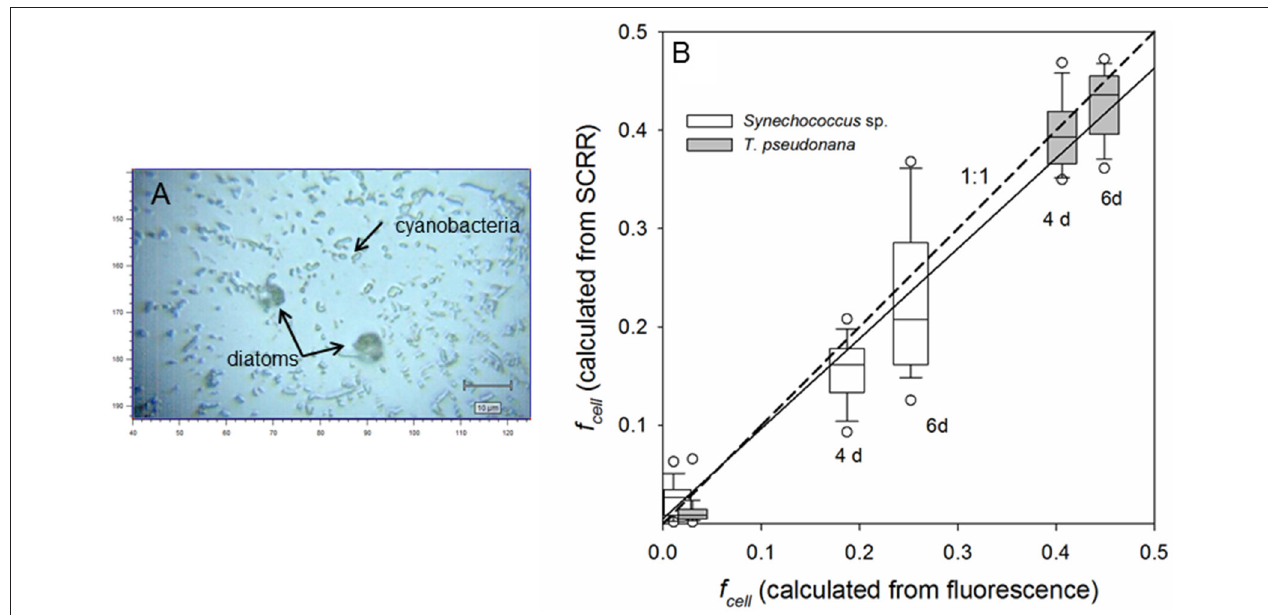
FIGURE 8 | Bright-field image (A) and measurement of fractional labeling (B) of single cells in artificial assemblages through time . Parallel cultures of a fast-growing diatom, Thalassiosira pseudonana ( µ pop = 0.483 day − 1 ) and a slow-growing cyanobacterium, Synechococcus sp. ( µ pop = 0.161 day − 1 ) in labeled ( f media = 0.48) and unlabeled ( f media = 0.011) were subsampled through exponential growth phase, mixed, and prepared for SCRR interrogation. Values of f cell computed from 1 ˜ ν C - C SCRR peak positions and Equation (4) in individual cells are compared with f cell computed from α , f media , population growth measured by in vivo (cid:10) (cid:11) fluorescence, and Equation (2) (B) . Solid line represents linear regression of all observations ( N = 253 cells) including natural 13 C abundance controls ( f cell ≈ 0.0107); f cell (SCRR) = 0.005 + 0.92 ± 0.02 f cell (fluorescence), r 2 =